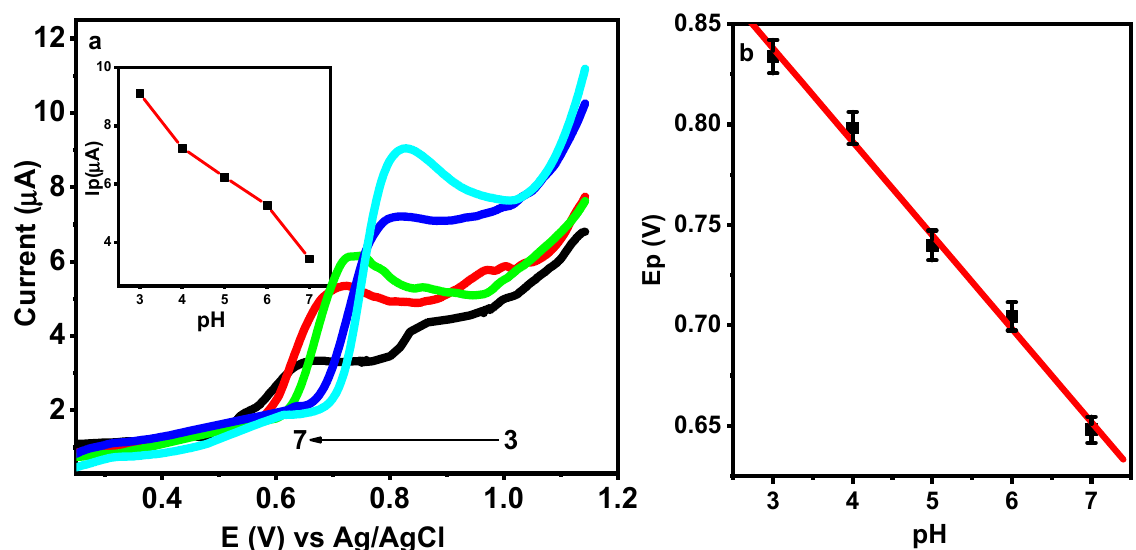
Figure 8. ( a ) LSVs of 0.5 µ M DIC in 0.1 M of BR buffer with different pH values at M-CHS NC/CPE at a scan rate 50 mV/s. Insets: Dependence of I p on pH. ( b ) Relation between the E p and pH values.